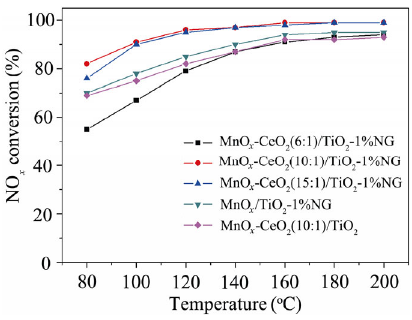
Fig. 8 SO 2 tolerance of (a) MnO x –CeO 2 (10 : 1)/TiO 2 – 1%NG, (b) MnO x –CeO 2 (10 : 1)/TiO 2 , and (c) MnO x / TiO 2 –1%NG at 160 . Reaction conditions: 500 ppm NO, ℃ 500 ppm NH 3 , 6% O 2 , 100 ppm SO 2 , and balance N 2 , GHSV = 30000 h –1